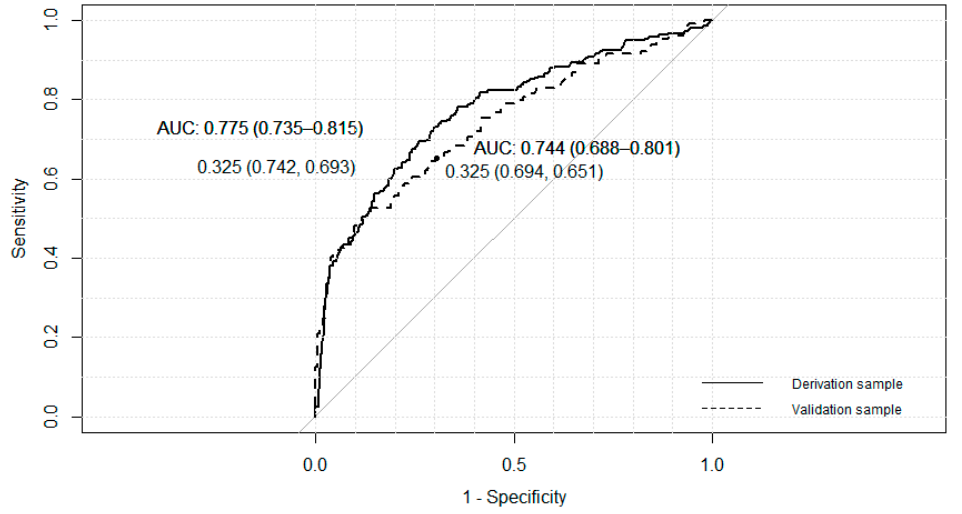
= Area Under the Curve.